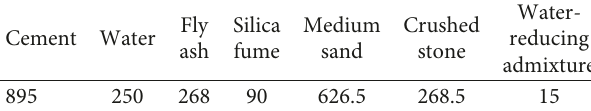
Table 1: Concrete mix of test specimens (kg/m3).